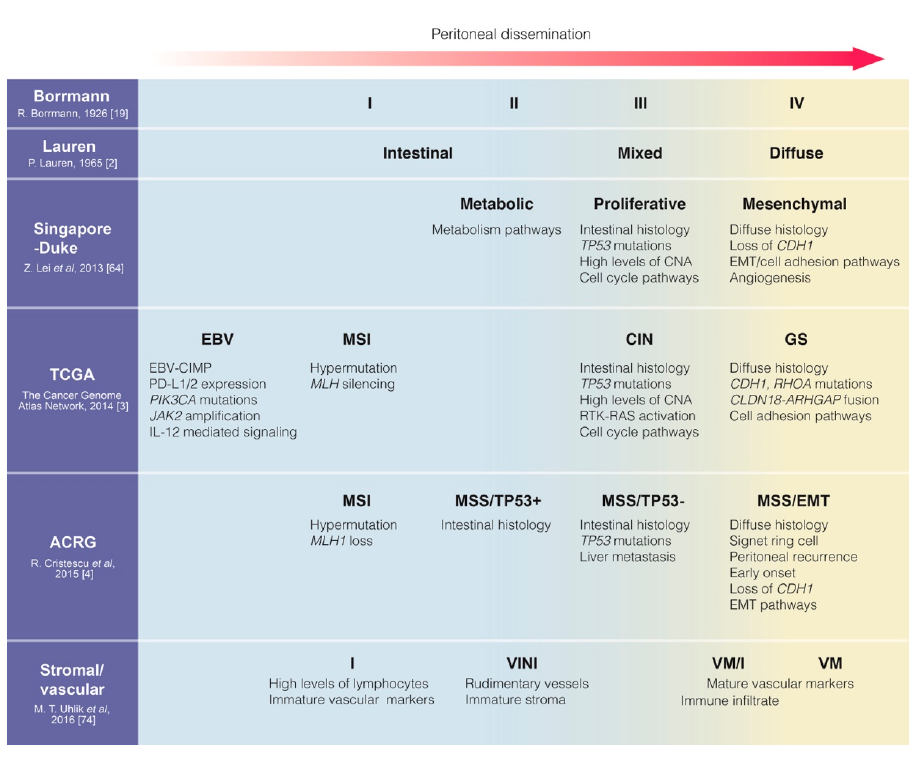
Figure 2. Molecular classifications of gastric cancer in association with propensity of peritoneal dissemination [2–4,19,64,74]. ACRG, Asian Cancer Research Group; CIN, chromosomal instability; CNA, copy number alteration; EBV, Epstein–Barr virus positive; EMT, epithelial-to-mesenchymal transition; GS, genomically stable; I, inflammatory; MSI/MSS, microsatellite instable/microsatellite stable; TCGA, The Cancer Genome Atlas; VINI, vascular immature/noninflammatory; VM, vascular mature; VMI, vascular mature/inflammatory. Reference numbers are shown in square brackets.